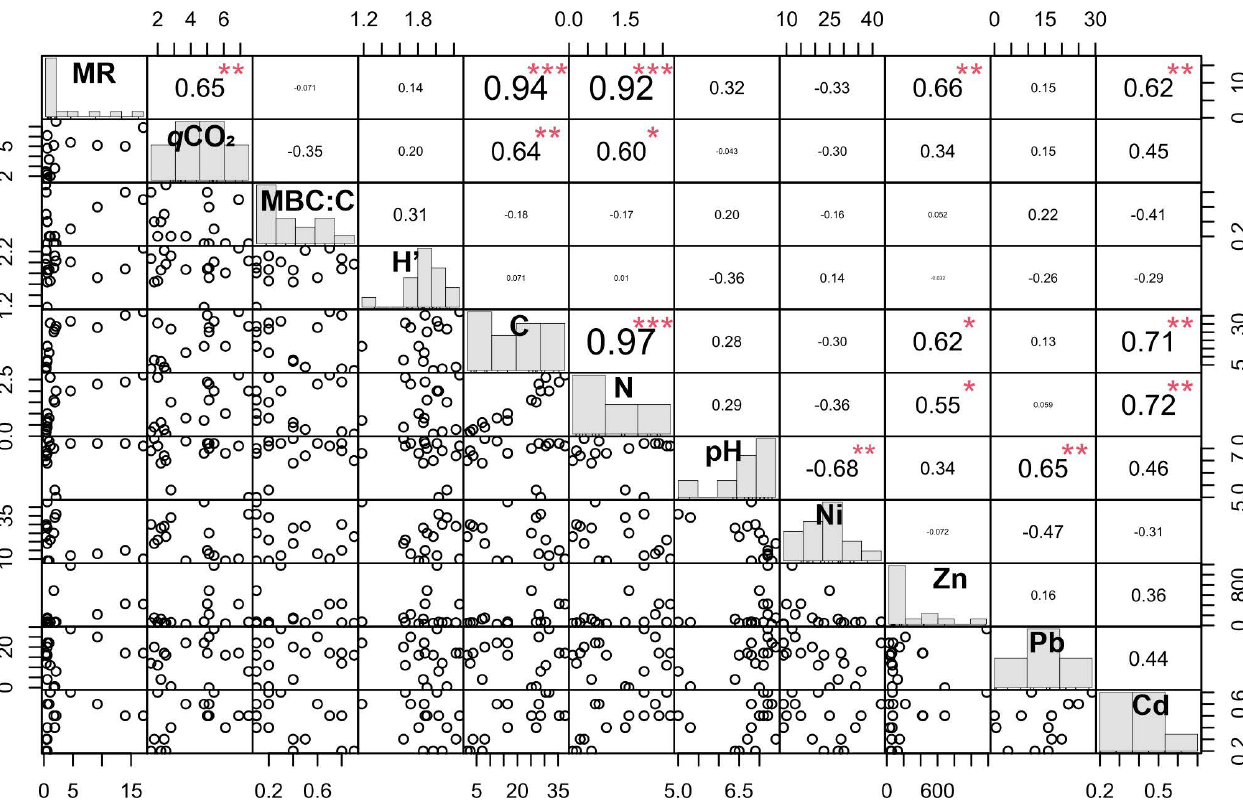
Figure 4. Relationships between microbial (MR, qCO 2 , MBC:C, H’) and chemical (C, N, pH, Ni, Zn, Pb, Cd) properties of the soil-like materials (n = 16). Significant correlation coefficients are indicated with * α ≤ 0.05; ** 0.01; *** 0.001.